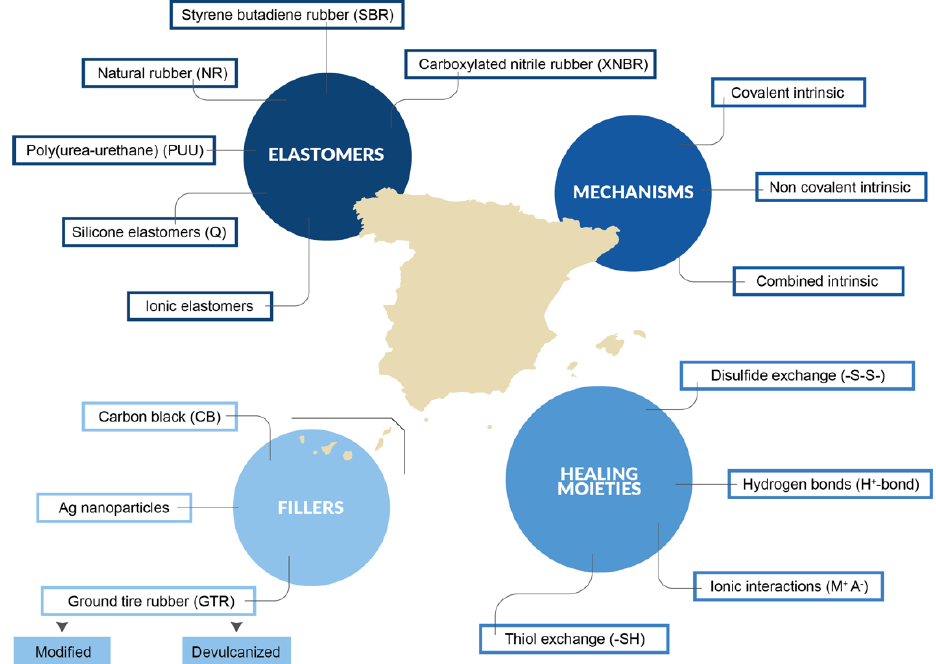
Figure 4. Self-healing elastomers contributions in Spain.